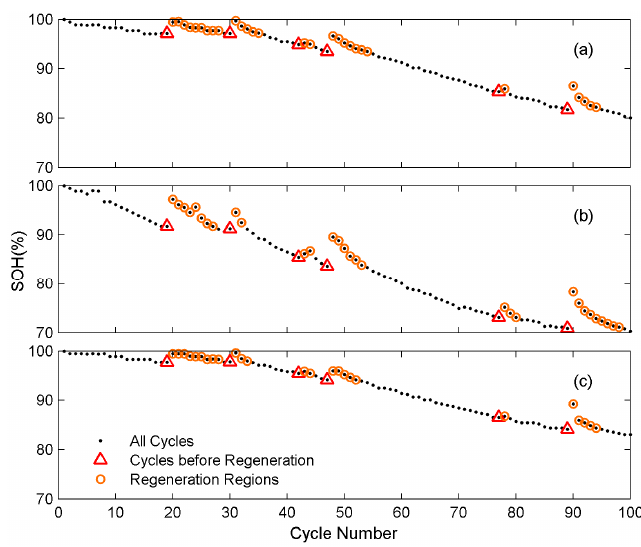
Figure 7. The extraction of regeneration influence: ( a ) battery No. 5; ( b ) battery No. 6; and ( c ) battery No. 7. Table 1. Cycle before regeneration and corresponding beginning time intervals.